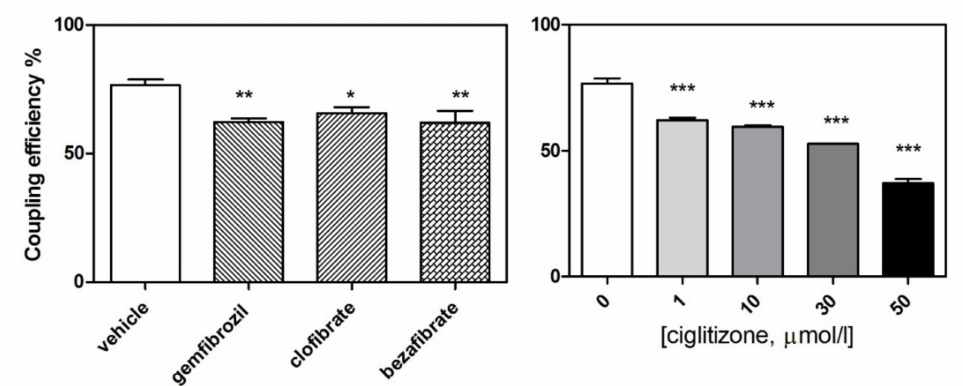
Figure 6. Coupled respiration (expressed as a percentage) in the HepG2 cell cultures treated with different PPAR ligands ( on the left ) and with increasing concentrations of ciglitizone ( on the right ) (* p < 0.05, ** p < 0.01, and *** p <